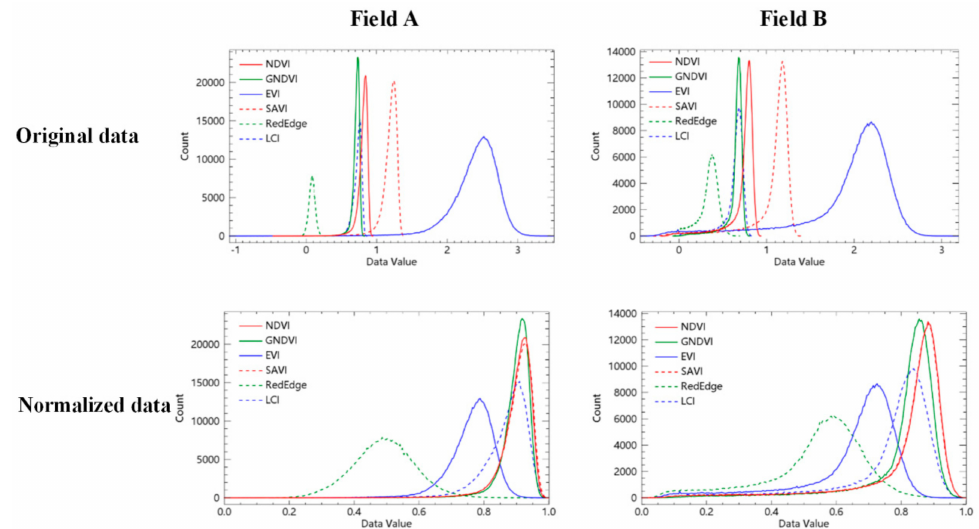
Figure 4. Histograms of six vegetation indices in the two experimental fields.